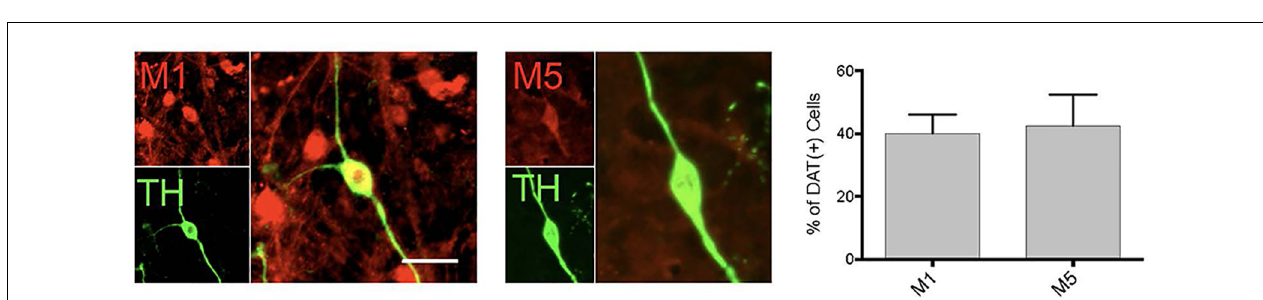
FIGURE 3 | DA neurons in primary midbrain culture also express muscarinic acetylcholine receptors. Cultured TH( + ) (green) neurons were found to also express M 1 and M 5 receptors (red). Quantitation of the number of TH( + ) neurons that also expressed M 1 or M 5 indicated that 40% of TH neurons expression expressed M 1 and 42.5% express M 5 [ n = 11 fields of view, 155 and 112 TH( + ) cells assessed for M 1 or M 5 co-expression, respectively; scale bar 25 µ m].